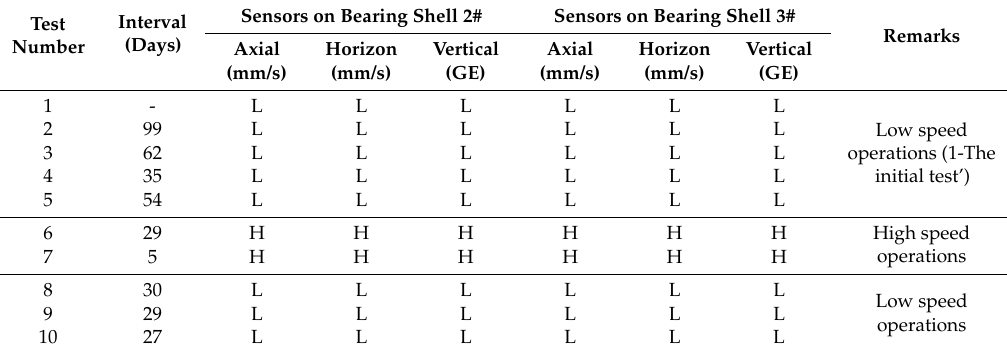
Table 5. Information of the 10 historical vibration tests (date, rotation speed,